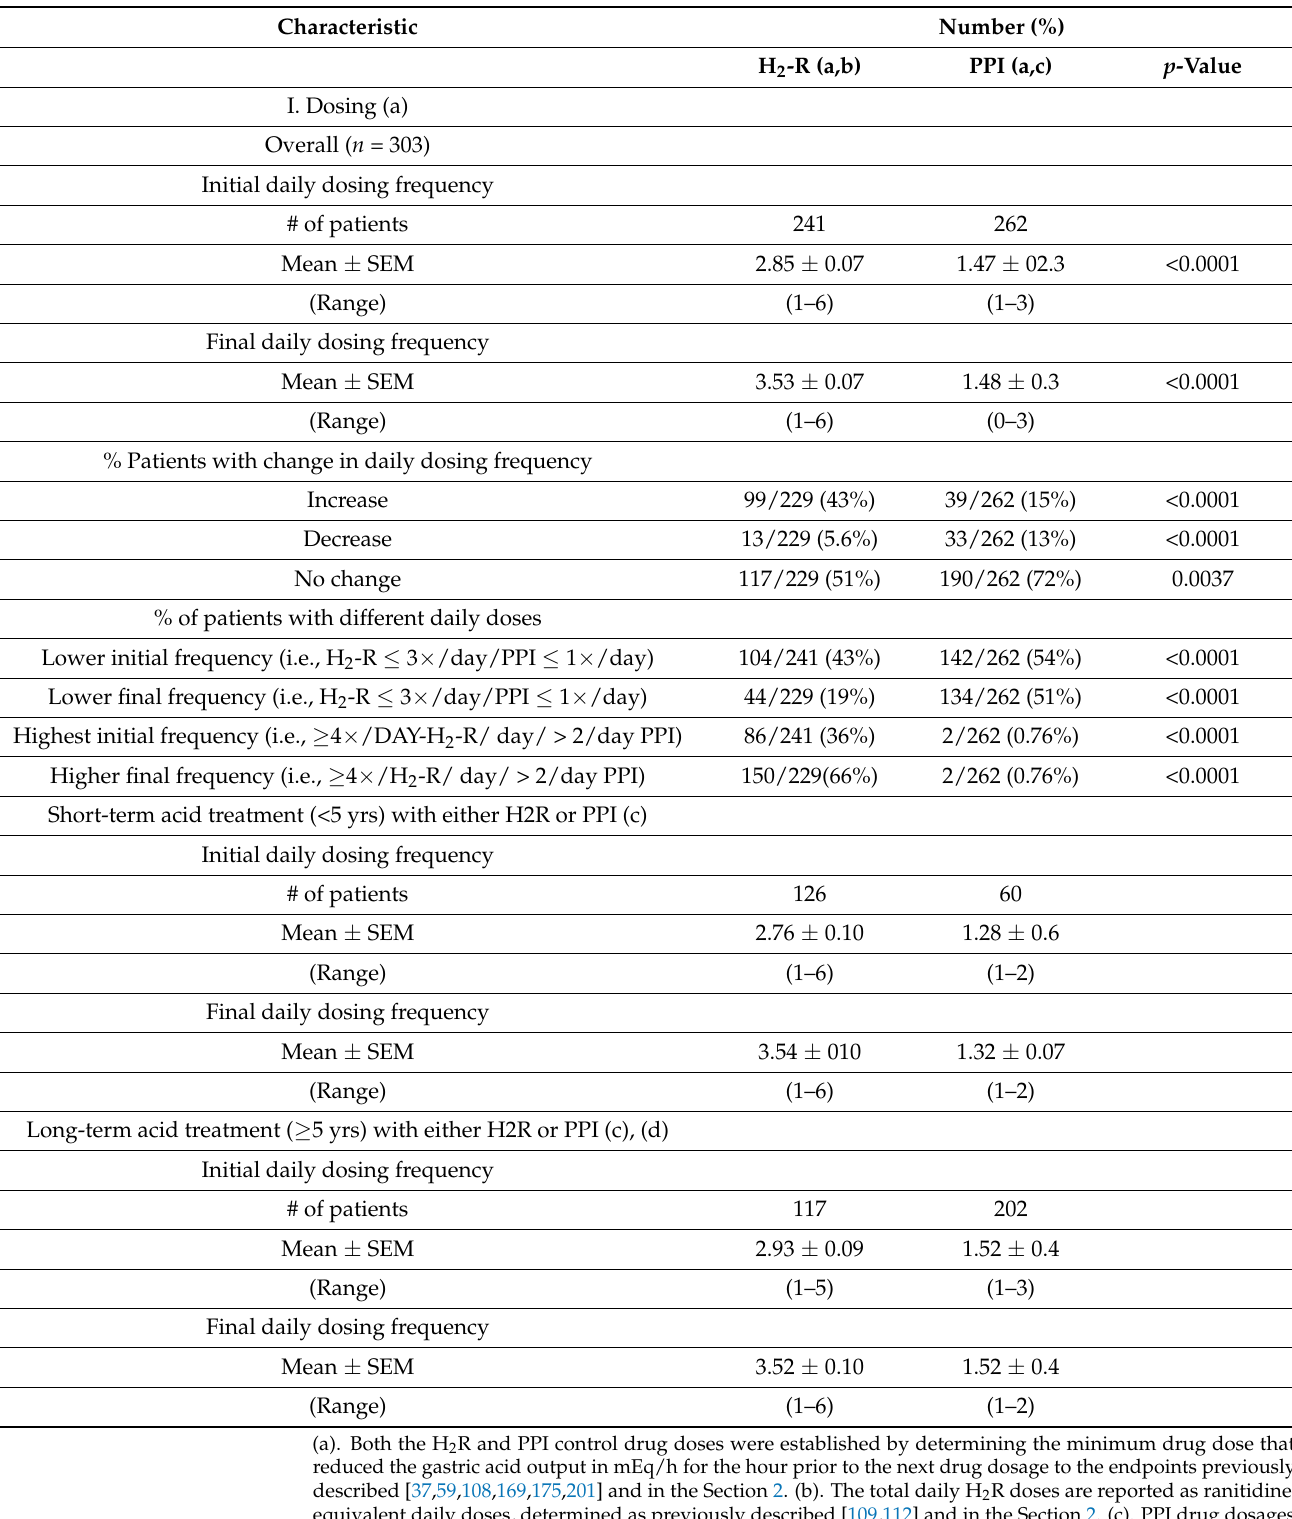
Table 5. Acid treatment: comparison of initial and final daily H 2 R and PPI dosing